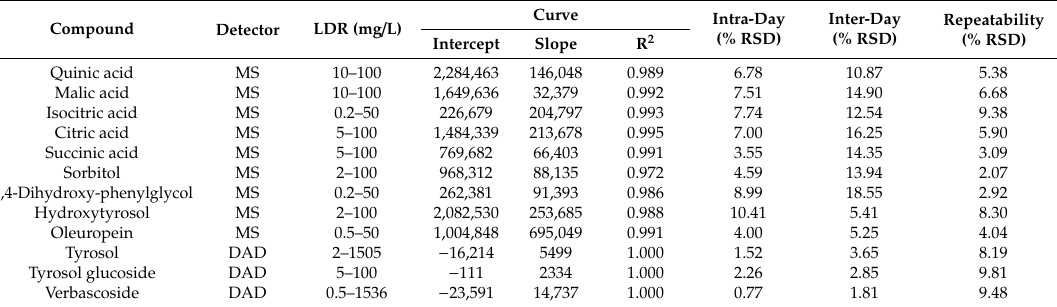
Table 2. Parameters of the calibration curves used for quantification and results of method validation.